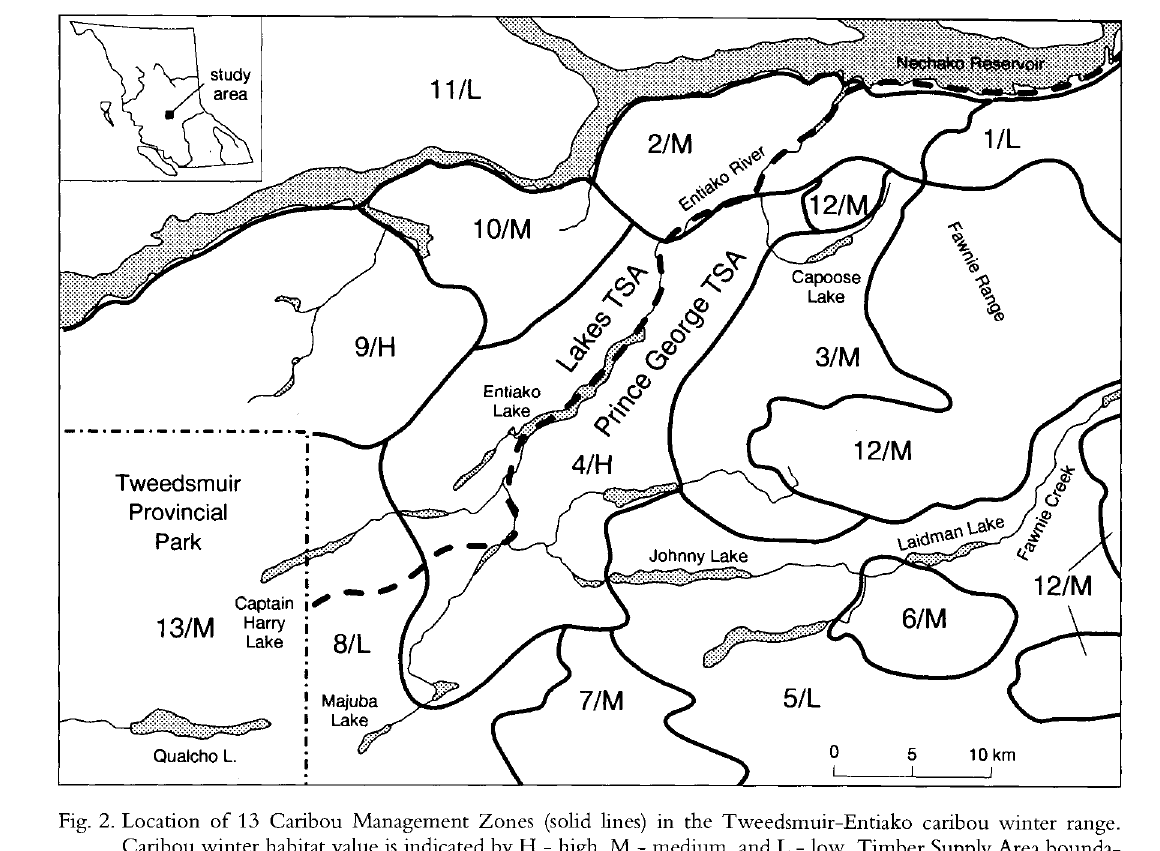
Fig. 2. Location of 13 Caribou Management Zones (solid lines) in the Tweedsmuir-Entiako caribou winter range. Caribou winter habitat value is indicated by H - high, M - medium, and L - low. Timber Supply Area bounda ry is indicated by a dashed line.